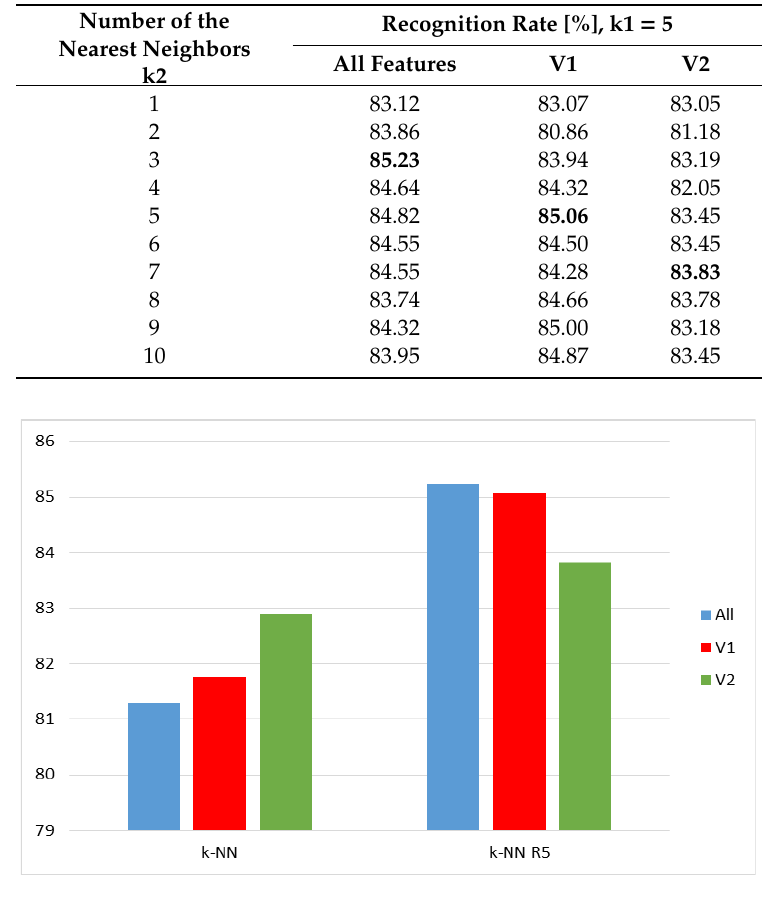
Table 12. Recognition rates [%] for the MSR Action 3D set and k-NN using representatives - best results for AS1, AS2, AS3 subsets (ten-fold cross-validation LOSO).